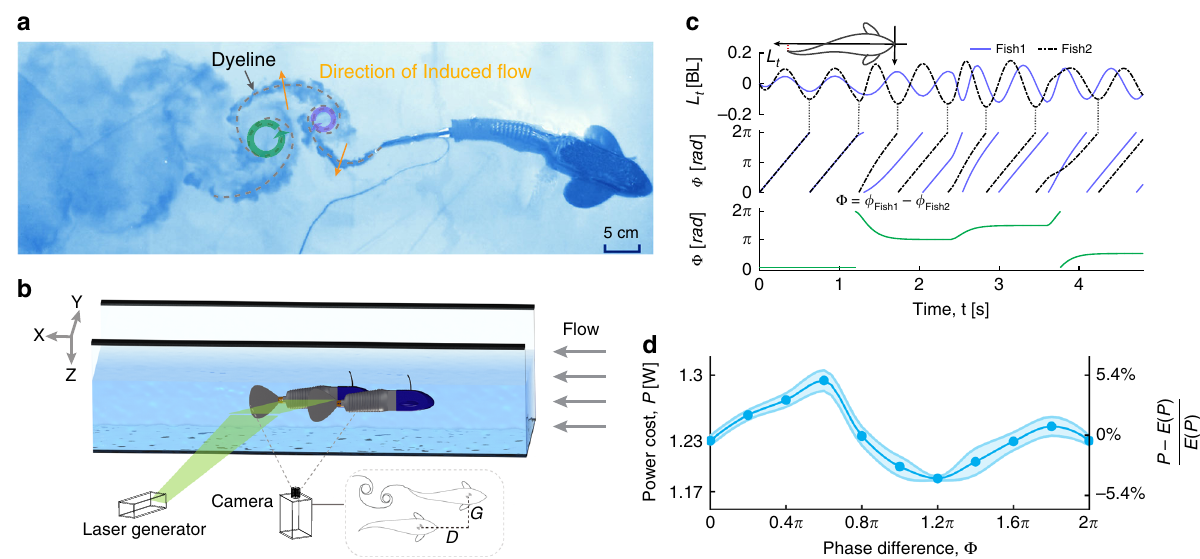
Fig. 1 The robotic fi sh platform employed to investigate hydrodynamic bene fi ts of schooling. a The reverse Karman vortices shedding by the robotic fi sh with dye fl ow visualisation. b Schematic view of the setup that allows setting various spatiotemporal differences between two robotic fi sh swimming in a fl ow tank (Front-back distance D ∈ [0.22, 1] BL (body length), Left-right distance G ∈ [0.27, 0.33] BL and Phase difference Φ ∈ [0, 2 π ]). A laser generator was used to visualise the hydrodynamic interactions (see Supplementary Note 1). c The phase difference Φ is evaluated by the difference between the undulation phase of the two robots. Undulation phase is evaluated based on the lateral position L t of the tail tip. d Power cost (absolute value on the left y - axis, and relative value compared to the average power cost on the right y -axis), is shown as a function of the phase difference at D = 0.33 BL and G = 0.27 BL. Error bars are standard error of the